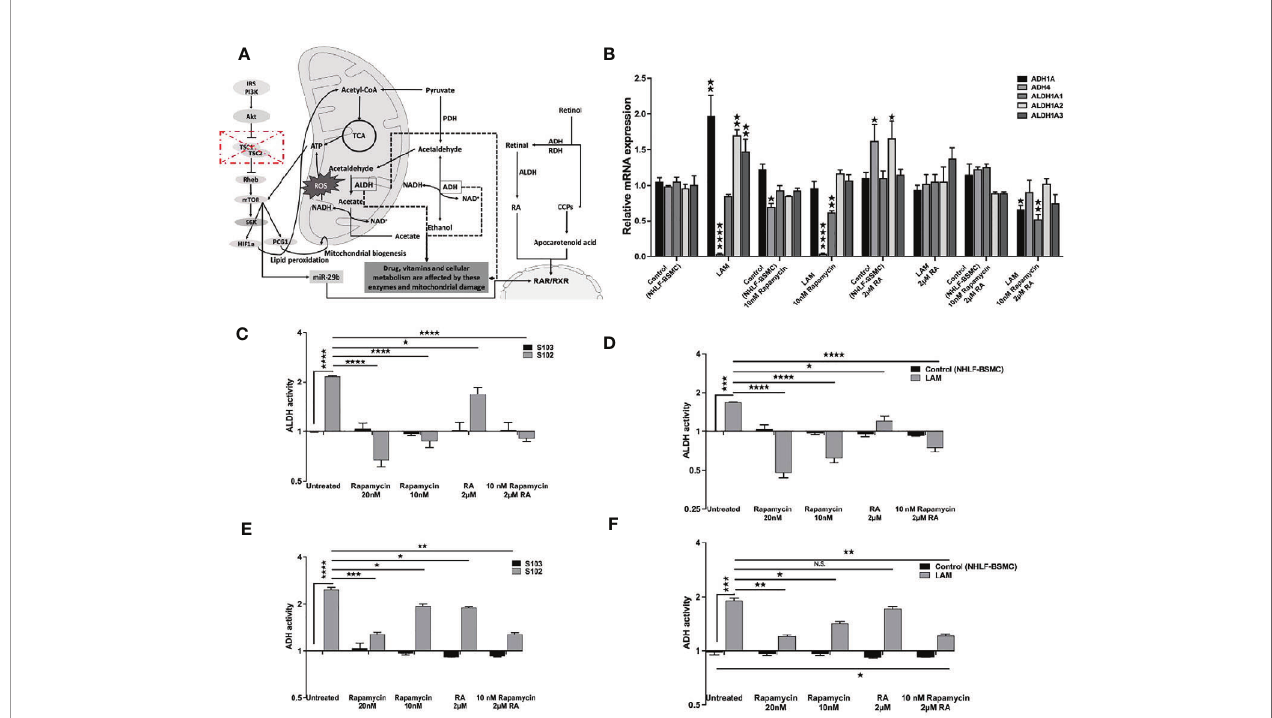
FIGURE 3 | The effect of RA on ALDH and ADH mRNA and enzyme activity levels. (A) Schematic fi gure explaining the connections between different pathways, TSC-mTOR, metabolic enzymes and energy production. (B) Gene expression levels of ALDH and ADH enzymes involved in RA metabolism following RA (2 m M) treatment of LAM cell lines compared to controls (BSMC and NHLF). Data are presented as mean LogRQ ± SEM compared to untreated controls. (C) ALDH enzyme activity fold changes in S102 (TSC-/-) cell lines compared to untreated S103 (TSC+/+) ±technical error of replicates (t-test). (D) ALDH enzyme activity fold changes in LAM cell lines compared to untreated BSMC and NHLF (1:1) ±SEM (ANOVA). (E) ADH enzyme activity fold changes in S102 (TSC-/-) cell lines compared to untreated S103 (TSC+/+) ±technical (t-test). (F) ADH enzyme activity fold changes in LAM cell lines compared to untreated BSMC and NHLF (1:1) ± SEM (ANOVA). Changes are marked as N.S. (Non Signi fi cant) or signi fi cant ★ , ★★ , ★★★ and ★★★★ (P<0.05, P<0.001, P<0.0002 and P<0.0001,